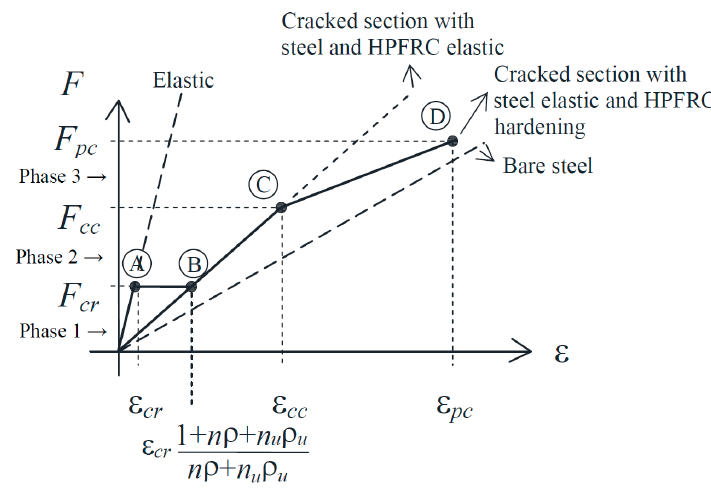
Figure 11. Load-strain diagram of the composite tension chord model.